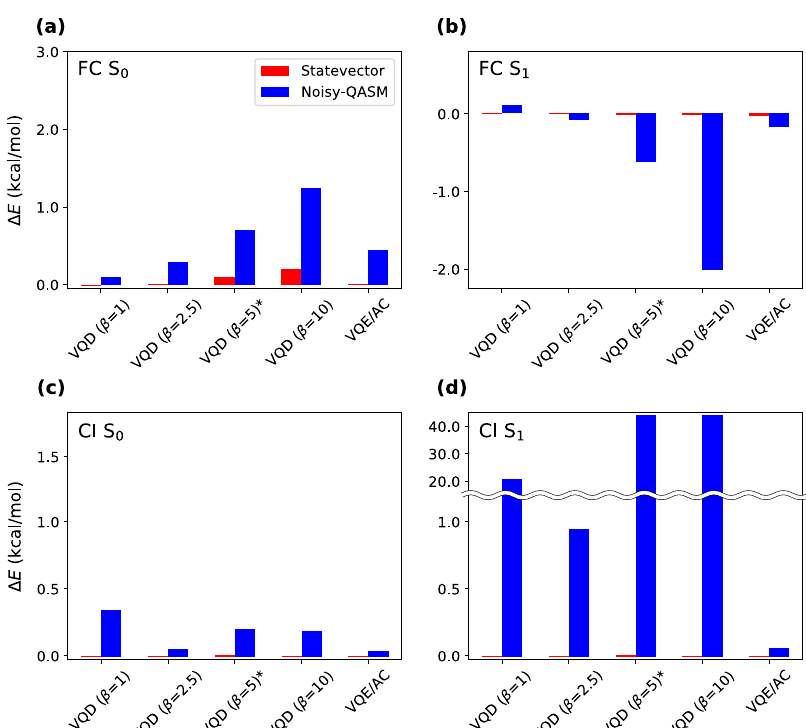
Fig. 6 Comparison of VQD with different parameter β and VQE/AC for ethylene. Energy deviations Δ E (in kcal mol − 1 ) from the exact values for S 0 at the FC ( a ), S 1 at the FC ( b ), S 0 at the CI ( c ), and S 1 at the CI ( d ) were calculated using the SA-CASSCF method. The errors in energy obtained by the statevector and noisy-QASM simulators are shown in red and blue, respectively. The results labeled with an ‘ * ’ indicate that the maximum number of orbital rotations was reached. Detailed values are shown in Supplementary Table